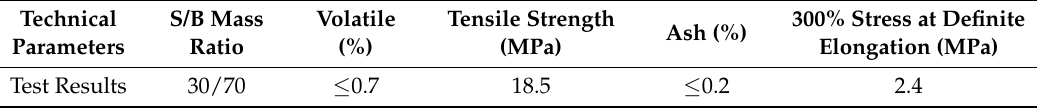
Table 2. Technical indicators of line type SBS modifier. 80